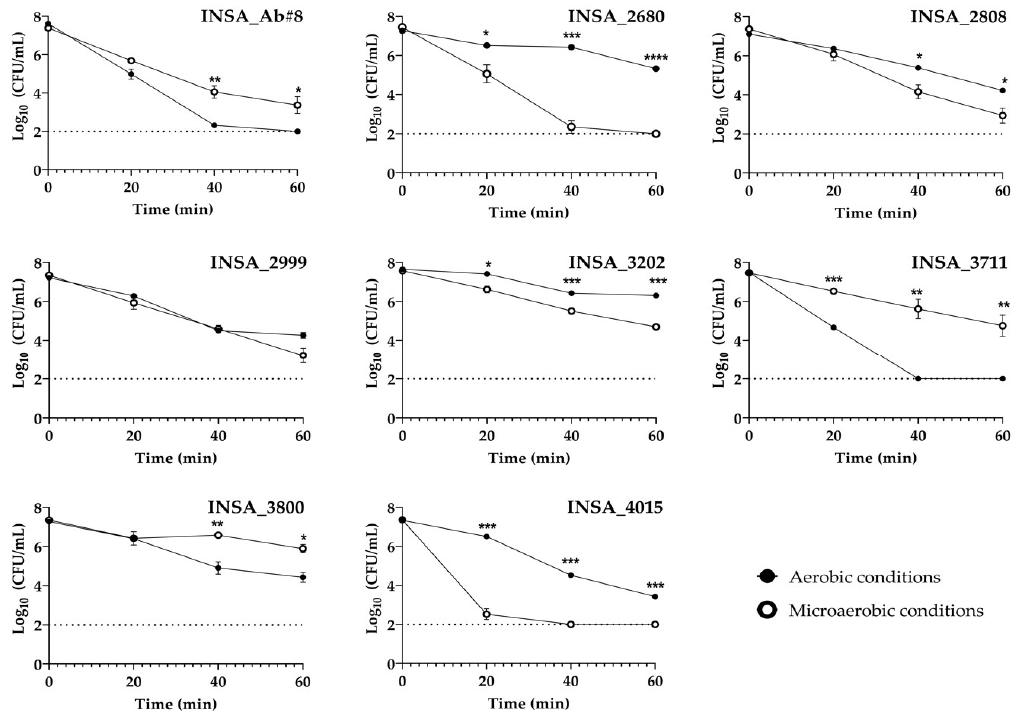
Figure 2. Effect of acidic stress in the survival of eight clinical isolates of Arcobacter butzleri when exposed to TSB medium at pH 4 while grown in aerobic and microaerobic conditions. The dashed line represents the detection limit of the assay. Results were analysed between atmospheric conditions using Student’s t -test. The data shown represent the mean ± standard deviation of at least three independent assays * p < 0.05, ** p < 0.01, *** p < 0.001, **** p <0.0001.